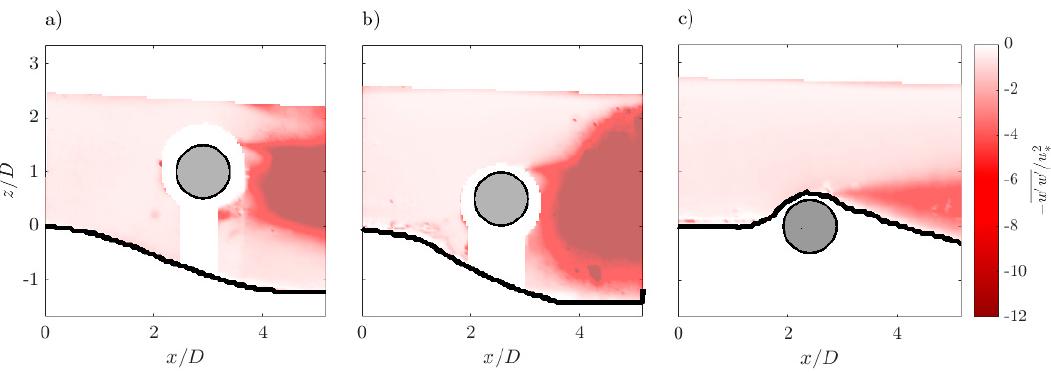
Figure 12. Dimensionless vertical Reynolds normal stresses on a vertical plane in ( a ) Run 1, ( b ) Run 2, ( c ) Run 3.